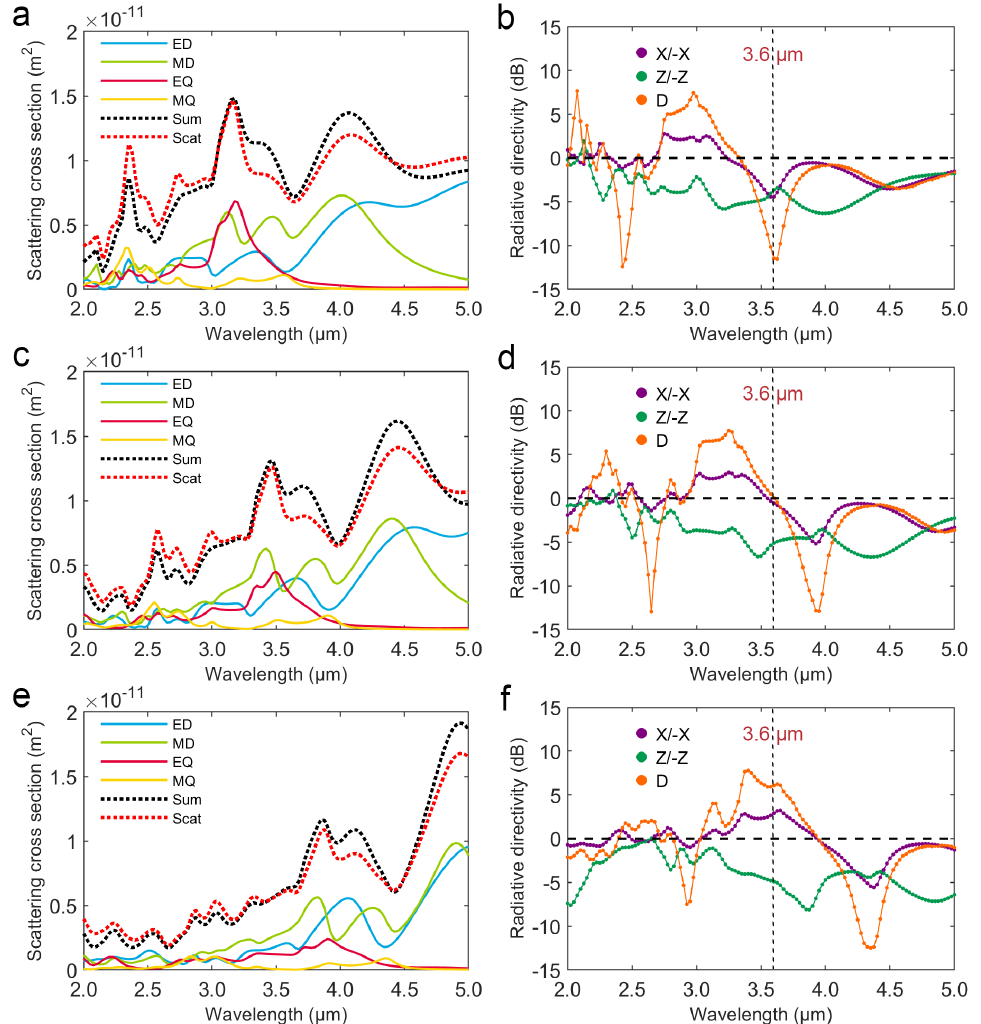
Figure 2. Multipole scattering cross sections and directivities of the V-shaped phase-change antenna in the 2.0 to 5.0 µ m wavelength range: ( a , c , e ) Scattering cross sections of ED, MD, EQ, MQ, their summation (Sum), and the total scattering cross sections calculated according to scattering field (Scat) at the crystallinity of 20%, 50%, and 80%, respectively; ( b , d , f ) Directivities of x -axis positive and negative (X/–X), z -axis positive and negative (Z/–Z), and the specific angle and window (D: θ 0 = 135°, δ = 10°) at the crystallinity of 20%, 50%, and 80%, respectively. To further investigate the continuous change of the V-shaped phase-change antenna’s scattering with the crystallinity, we calculated the multipole scattering cross sections and directivities of the V-shaped phase-change antenna in the crystallinity between 0% and 100% at 3.6 µ m wavelength, which are shown in Figure 3a,b, respectively. It can be